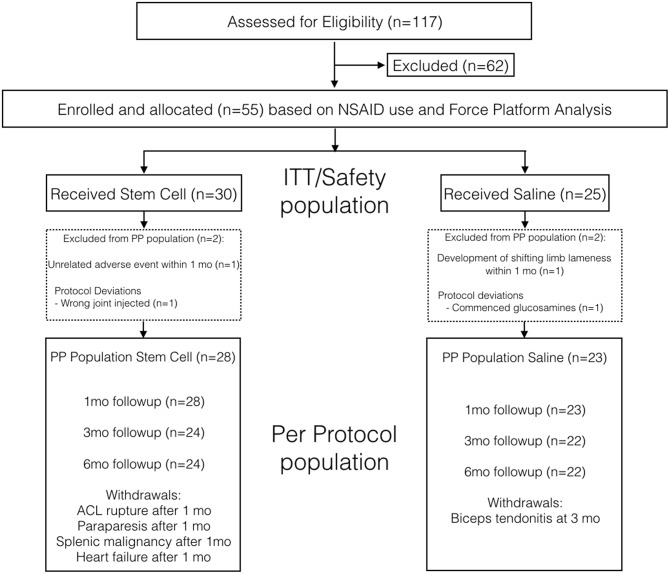
Case flow indicating how the safety (intent to treat) and per protocol populations were identified for the UMSC and placebo treatment groups.